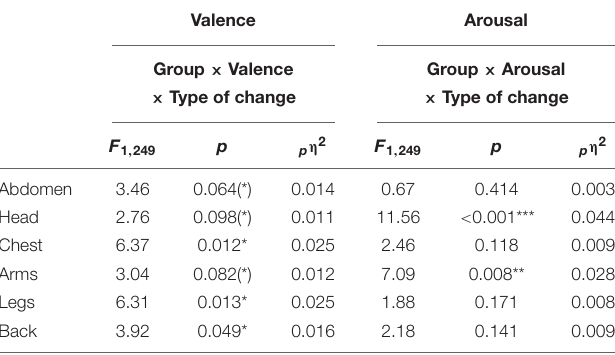
TABLE 3 | Interaction effects between the factors “Group” (IBD/HC), “Valence” (positive/negative), “Arousal” (relaxed/tensed), and “Type of change” (activation/deactivation) for all predefined ROI.